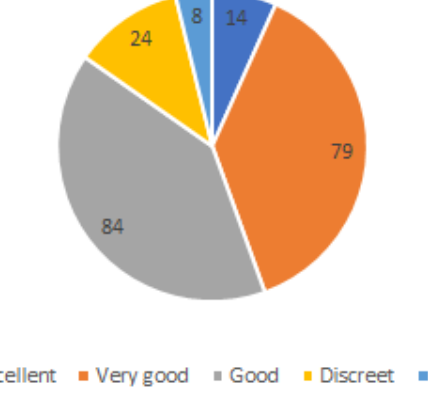
Figure 6. Respondents by perceived health status.